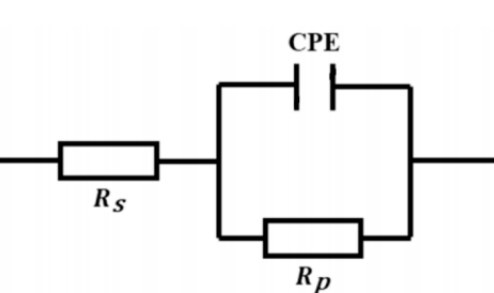
Figure 5. The equivalent circuit model applied to fit and simulate the impedance data.